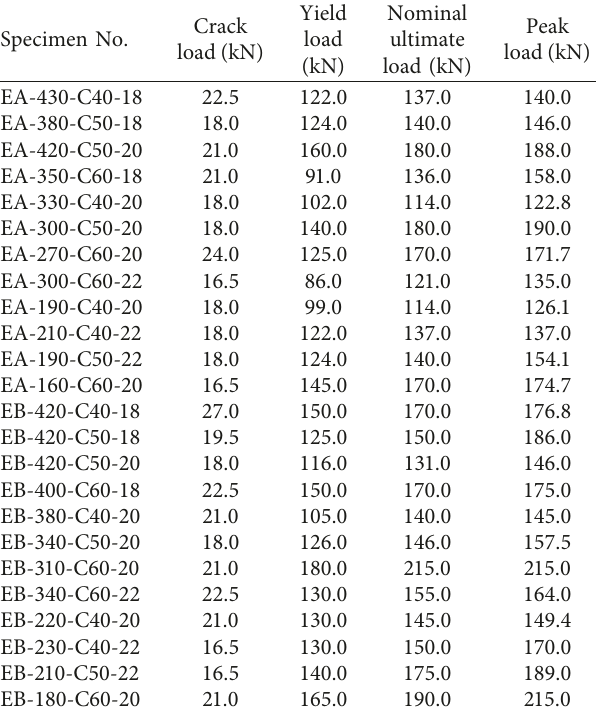
Table 5: Load of the exterior beam-column connection at char- acteristic points. Specimen